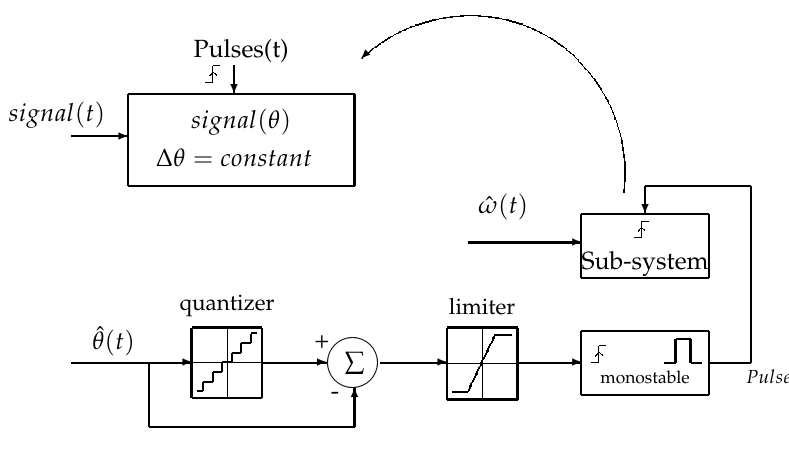
Figure 6. Block diagram of the online resampling.